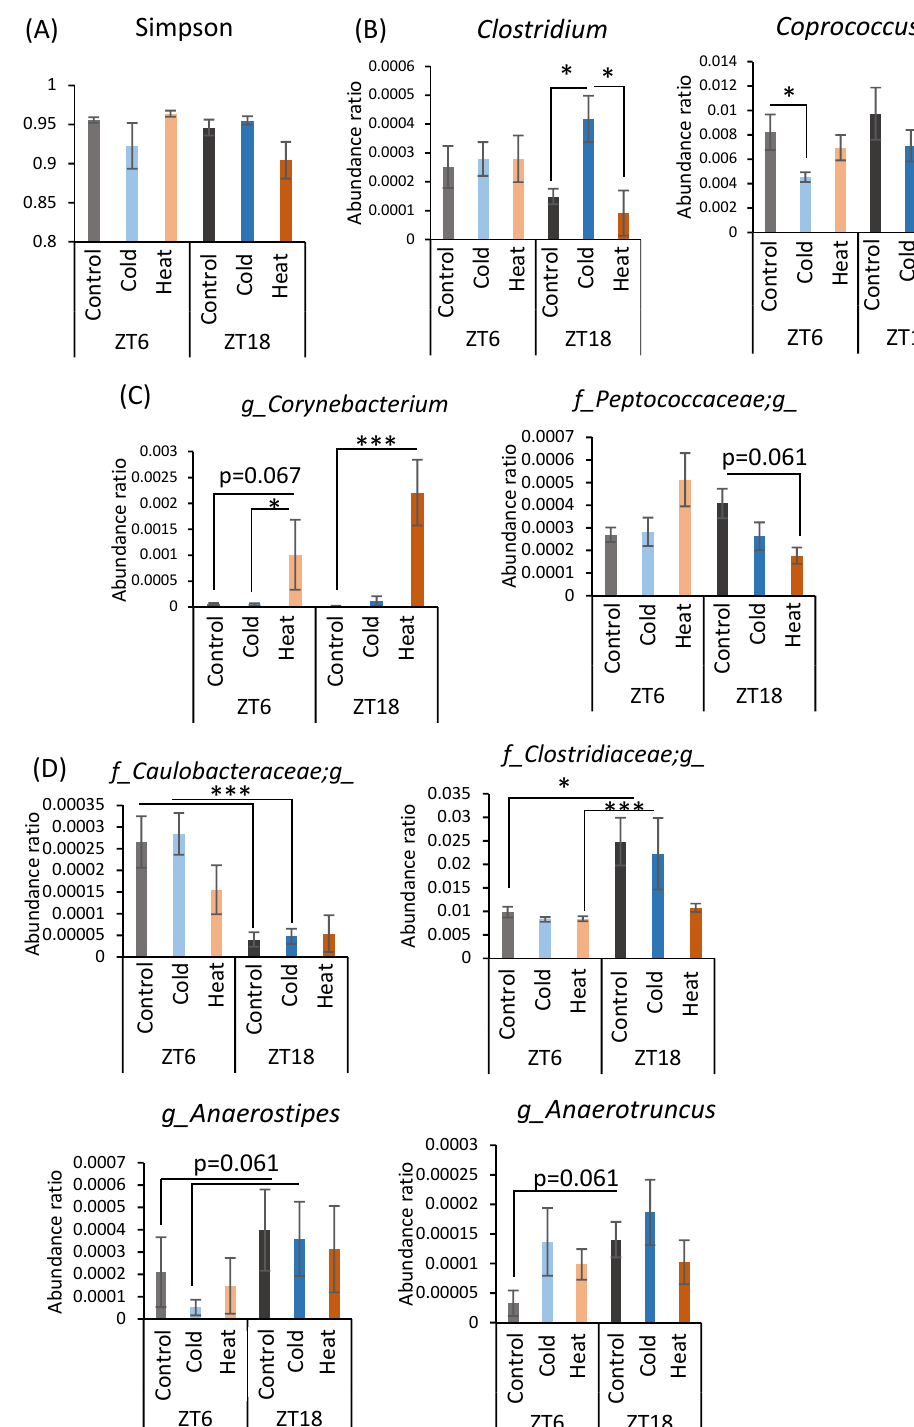
Figure A1. Effects of cold or heat exposure on α -diversity and the relative abundance of microbes at the genus level. ( A ) α -diversity (Simpson). ( B ) Changes in gut microbiota at the genus level due to cold exposure. ( C ) Changes in gut microbiota at the genus level due to heat exposure, ( D ) Changes in gut microbiota at the genus level due to the timing of mice exposed to 22 or 7 °C for 3 h a day for 10 days. Data are represented as mean ± SEM ( n = 7–12). * p < 0.05 *** p < 0.001 evaluated using two-way ANOVA with Sidak’s post hoc analysis. Table A1. Correlation between bacteria with altered abundance and short-chain fatty acids. p_Bact eroidet es p_Fir micute s